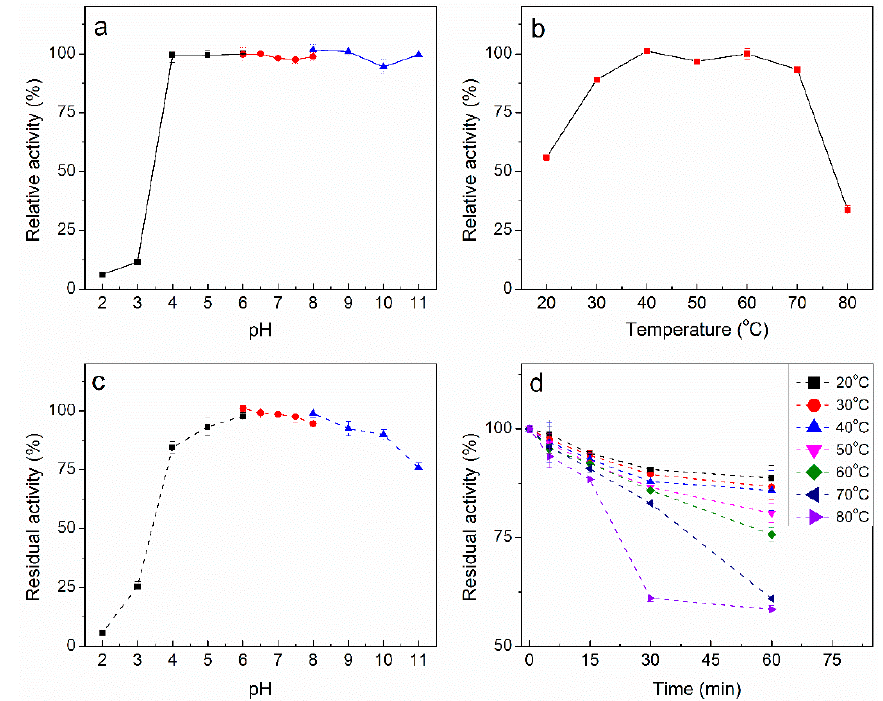
Figure 5. Effect of pH and temperature on activity and stability of Pp Abf51b. ( a ) Optimal pH and ( c ) pH stability were determined by incubating samples at various pH values for 15 min at 40 °C. ( b ) Optimal temperature and ( d ) temperature stability were determined by incubating samples at various temperatures at pH 6.5 for 15 min. The enzyme activity was detected by using p NP α Ara f as a substrate (1 mM). The following buffers were used: 50 mM acetate buffer, pH 2.0–6.0; 50 mM phosphate buffer, pH 6.0–8.0; and 50 mM glycine sodium buffer, pH 8.0–11.0.